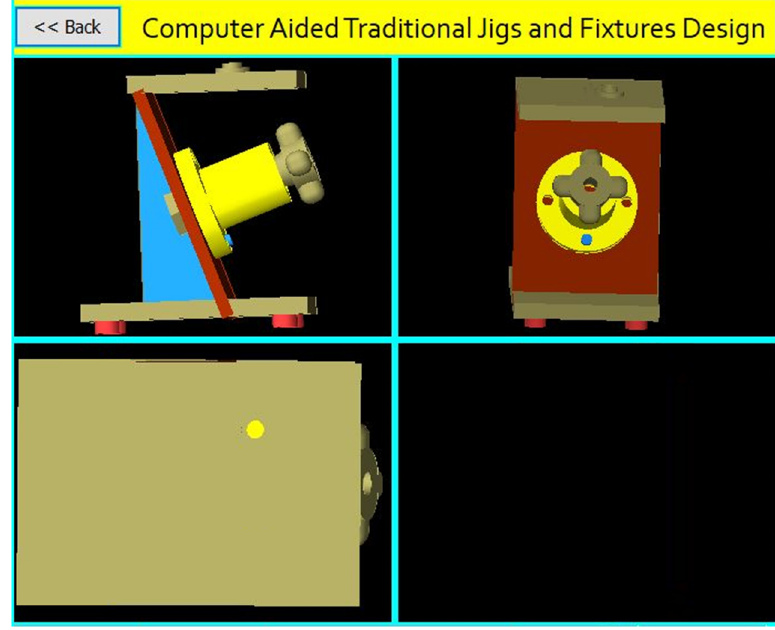
Figure 38. The jig views.